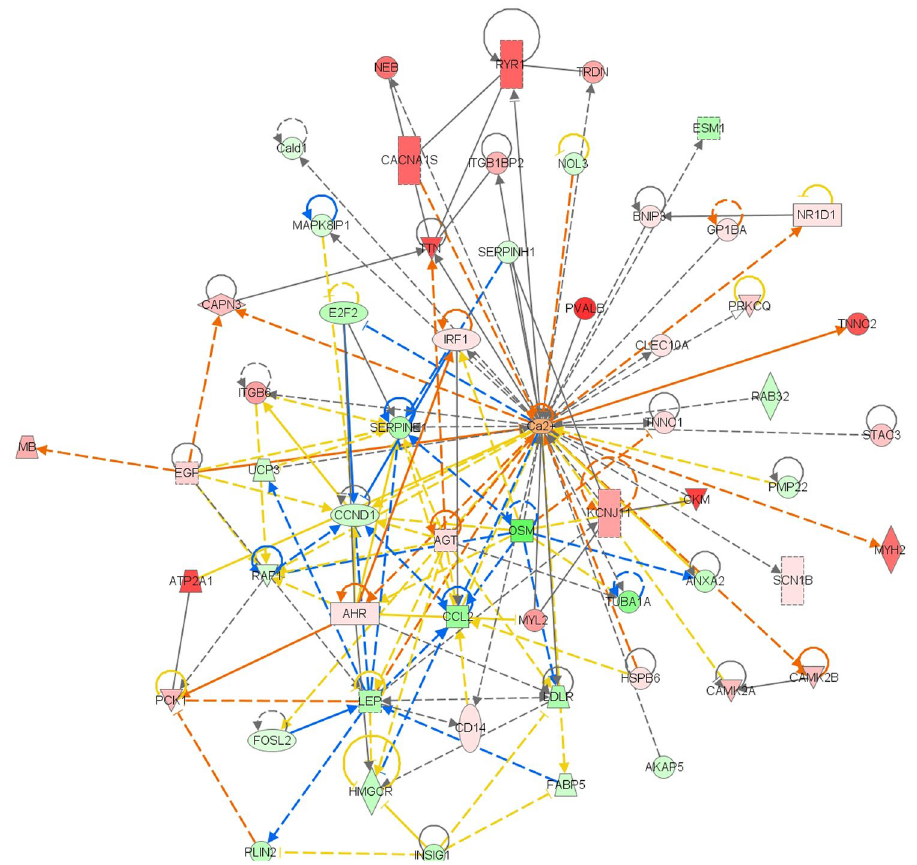
Figure 8. The mechanistic regulatory network, based on calcium ion and DEGs identified between HS group and NS group, by IPA